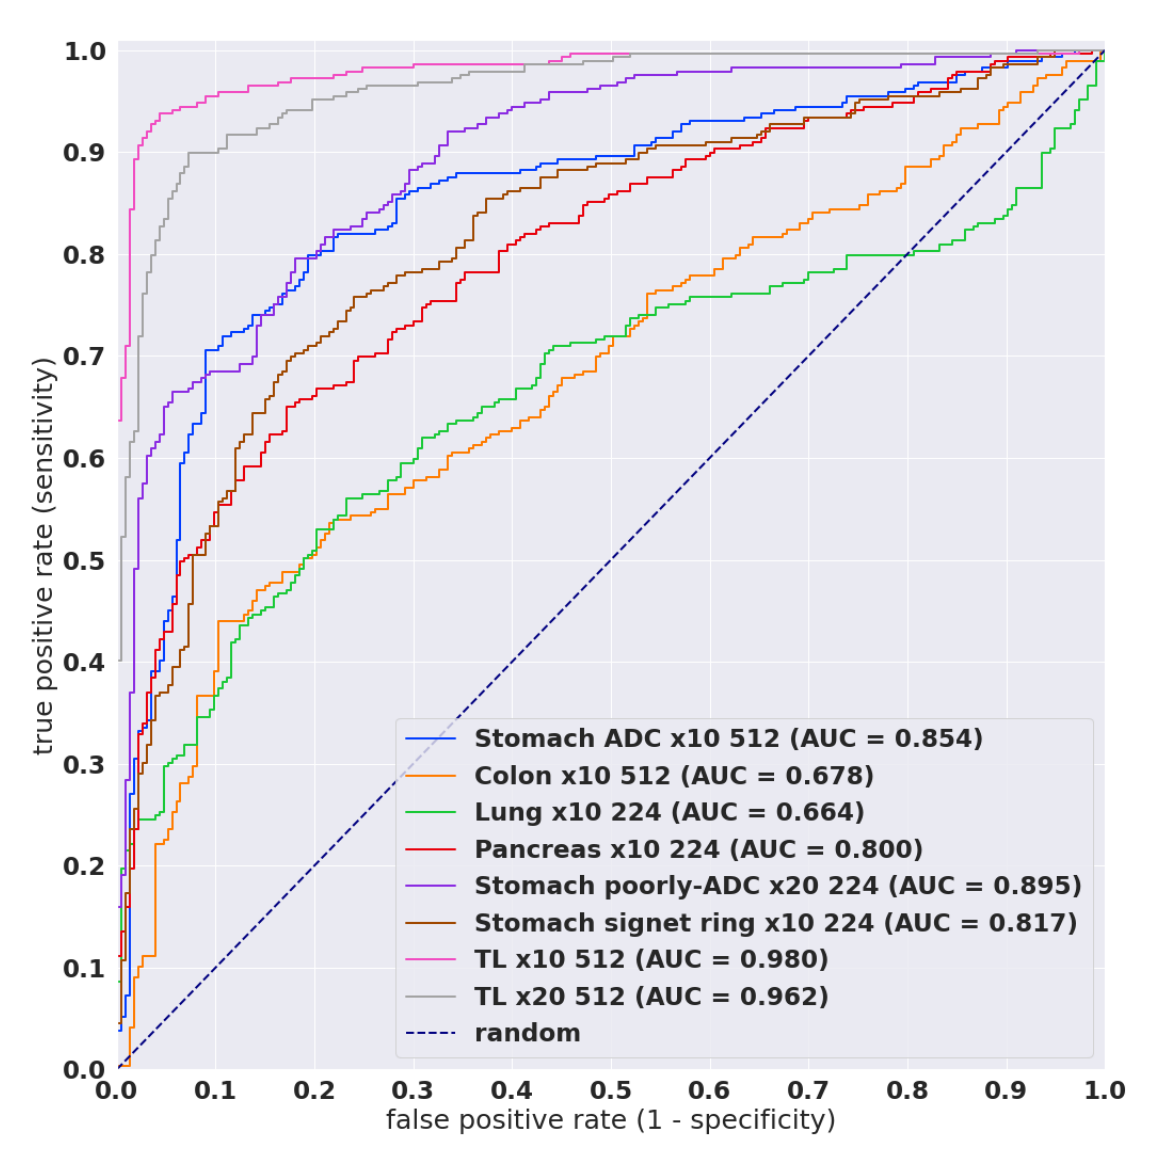
Figure 2. ROC curves for the various existing models as well as models trained via transfer learning (TL) on core needle biopsy test set from Hospital 1. The trained models were TL x10 512 B1 and TL x20 512